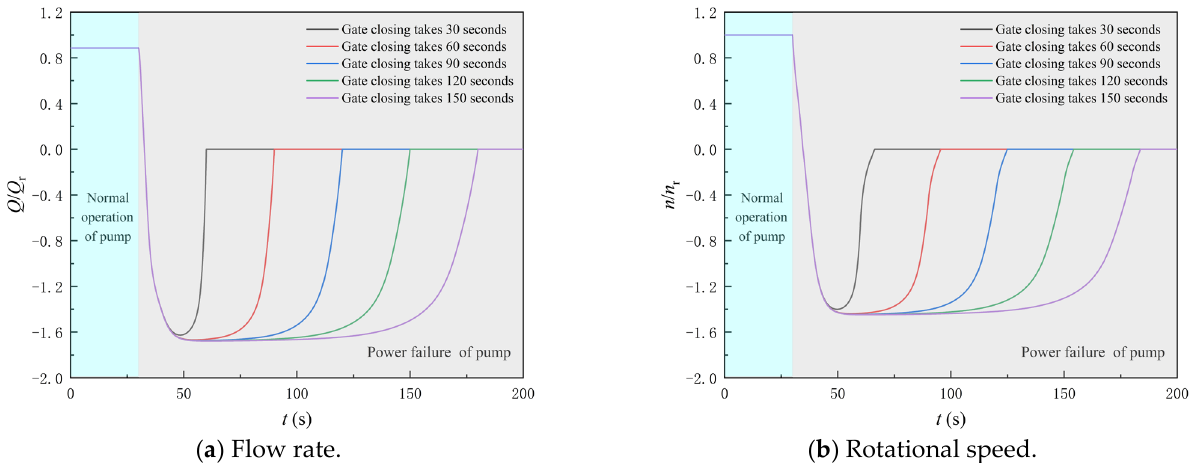
Figure 13. Variation of the flow and rotational speeds with time at different gate closing